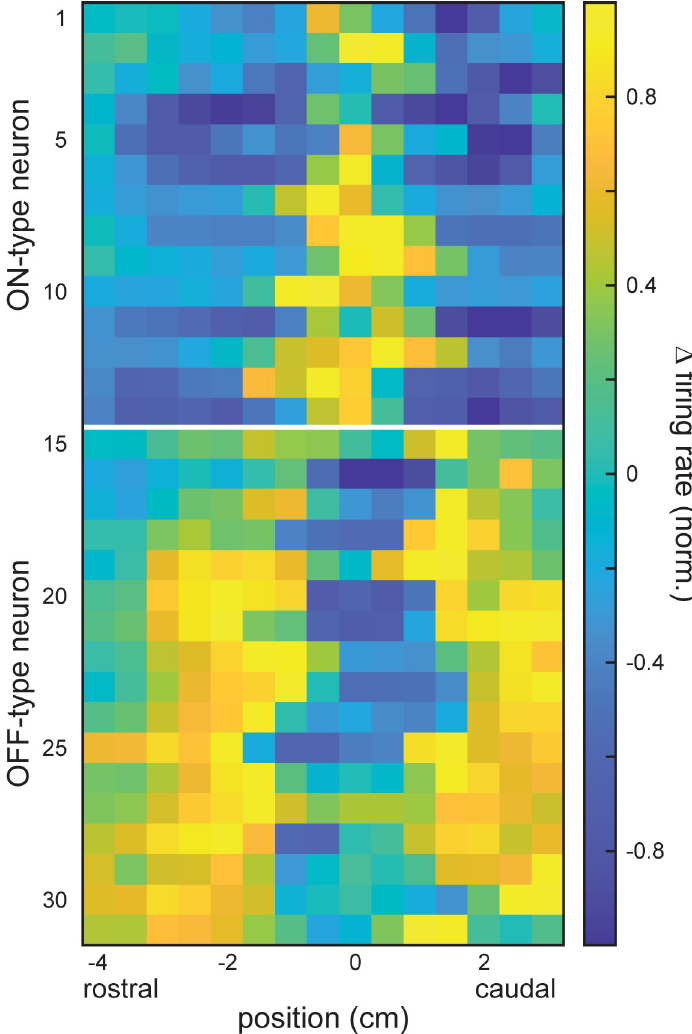
Fig 3. Example receptive fields from ON and OFF-type ELL pyramidal cell populations. Color plot showing the receptive fields of 32 simultaneously recorded neurons (14 ON-type neurons listed first, followed by 17 OFF-type neurons) visualized as the change ( Δ ) in normalized firing rate as a function of stimulus position. between neural responses (i.e., spike-count correlations; S1 Fig). Further, because previous studies have shown that correlations between neural responses are strongly influenced by cor- relations between the baseline activities (i.e., in the absence of stimulation) [29, 54], we investi- gated whether, and if so, how the spatial dependence of correlations under stimulation varies as a function of baseline correlations. Overall, we found that baseline correlations varied over a wide range and decayed in magnitude as a function of the distance between neurons (Fig 5A; see S2 Fig for the raw baseline correlation values), which agrees with previous results [29, 54]. By applying a threshold at |r | = 0.15 (Fig 5A, red line), we separated neural pairs into those BL with high baseline correlation magnitude (i.e., “high |r | pairs”) and those with low baseline BL correlation magnitude (i.e., “low |r | pairs”). We then found that the spatial dependence of BL the correlation was greater for high |r | pairs than for low |r | pairs (Fig 5B and 5C; Wil- BL BL coxon rank sum test for b: p = 2.1 � 10 − 128 ). Indeed, for high |r | pairs, spike-count BL